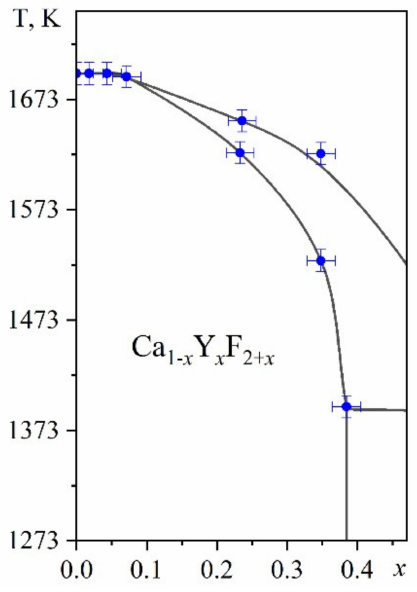
Figure 3. The part of the phase diagram of the CaF 2 –YF 3 system in the field of formation of the Ca 1– x Y x F 2+ x fluorite